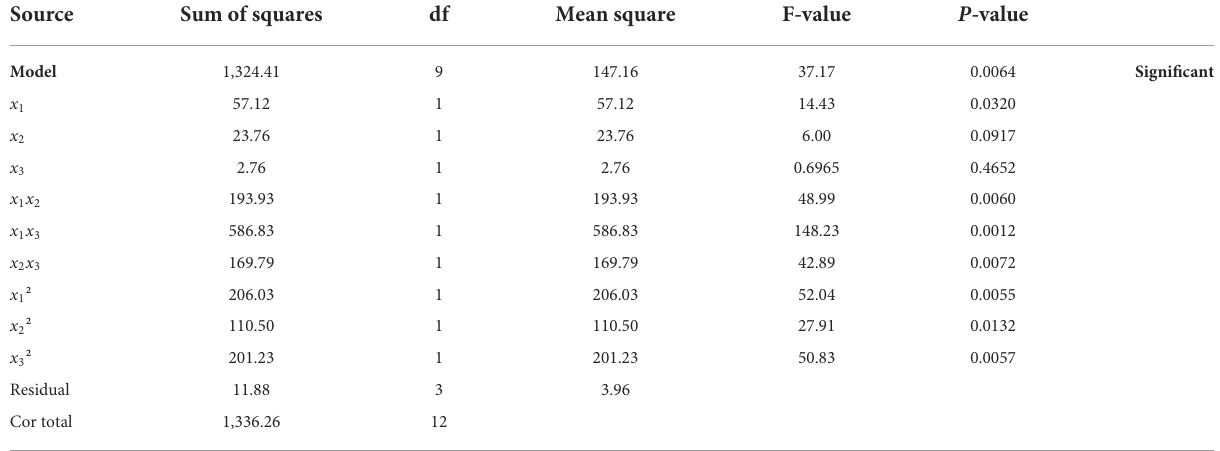
TABLE 2 ANOVA for quadratic